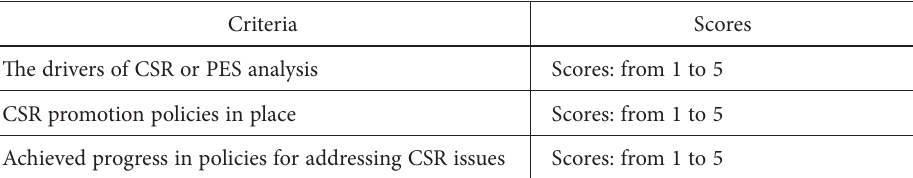
Table 1. The main criteria for the assessment of CSR performance (source: created by the authors)